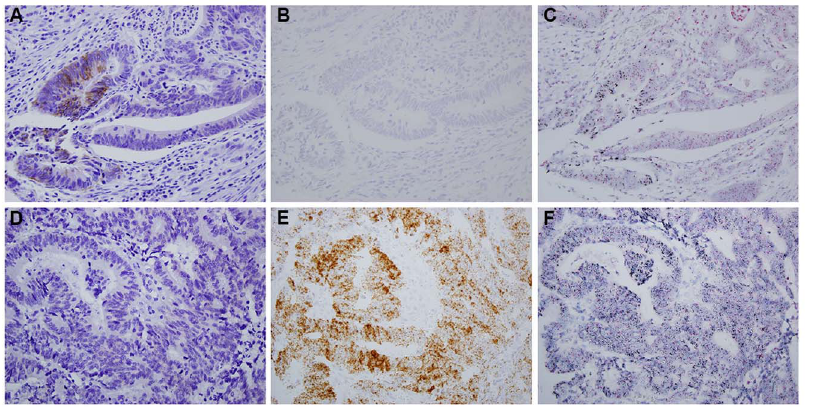
Figure 2. Representative figures of the cases with gene amplification and mRNA overtranscription, but without HER2 protein overexpression. (A–C) HER2 IHC 1 + in cancer focal area (A), focal mRNA overtranscription (B) and HER2 gene amplification (C) in accordance with protein expression area. (D–F) No expression of HER2 protein (D), but diffuse mRNA overtranscription (E) and HER2 gene amplification (F) in one case.